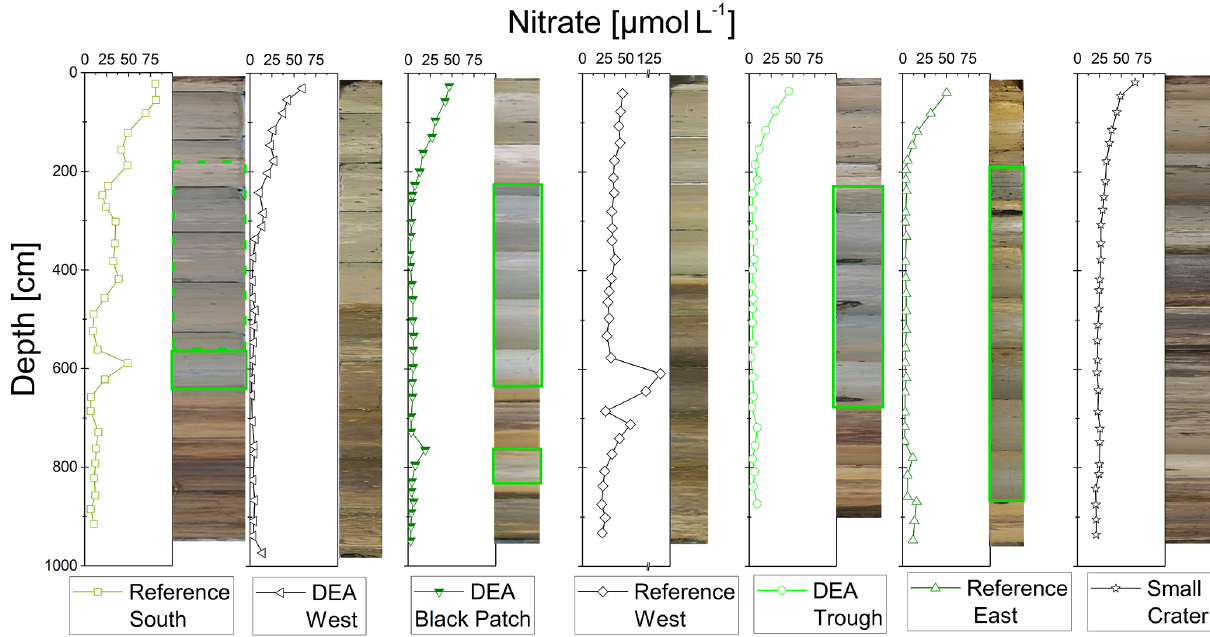
Figure 3. Combined photos of the individual GCs with corresponding nitrate profiles. Green layers are marked with green boxes.